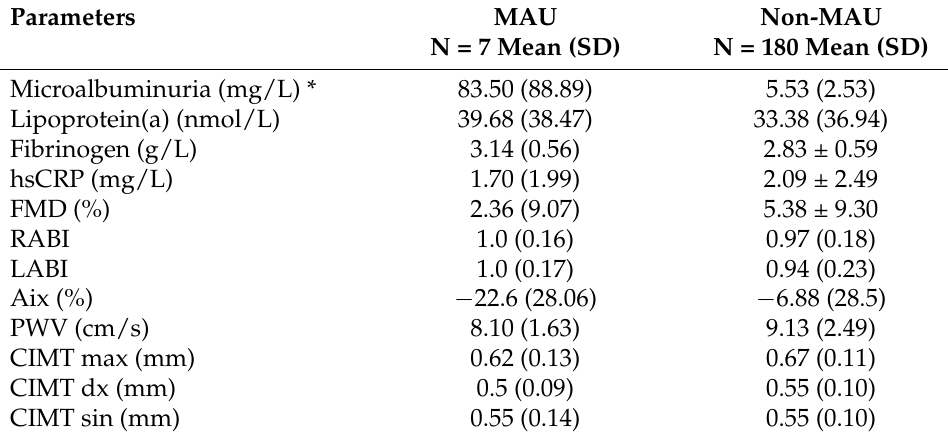
Table 2. Comparison of mean values and standard deviations of continuous biochemical, functional, and morphological markers of subclinical atherosclerosis between groups with and without microal- buminuria assessed with t-test. No statistically significant differences were